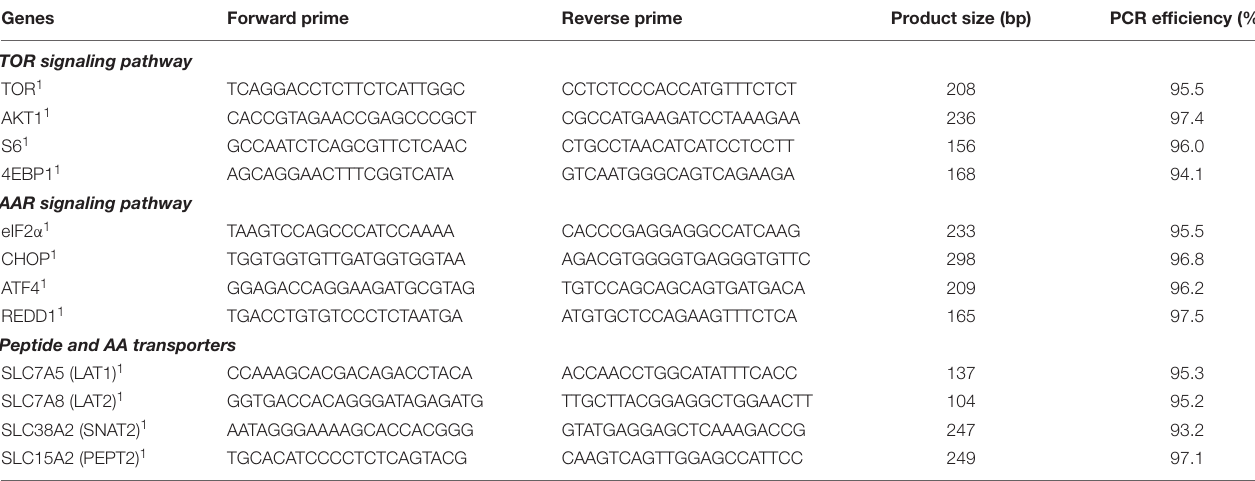
TABLE 3 | Primer sequences used for real-time quantitative